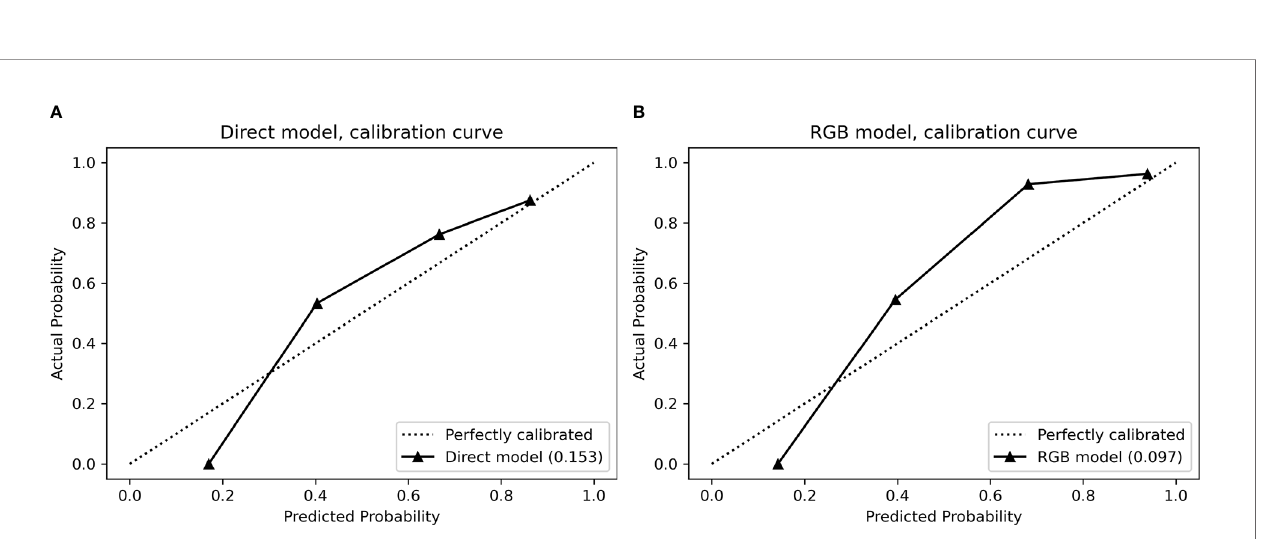
FIGURE 4 | Calibration curves for (A) direct model and (B) RGB model performed in the validation cohort. The calibration curves demonstrated a statistical goodness-of- fi t measurement of the models in the characterization of focal liver lesions. The solid line represented the performance of the models, and the dotted line represented an ideal model. The lesser the solid line deviated from the dotted line, the better the calibration of the model.